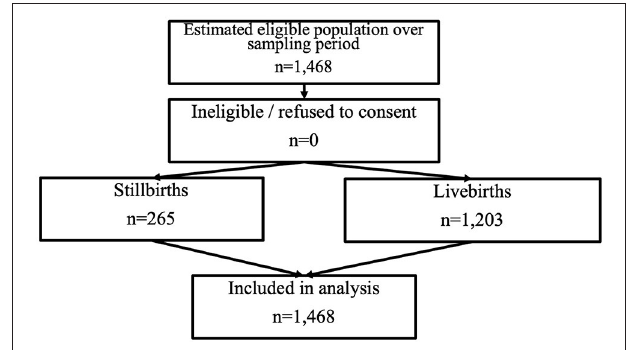
FIGURE 3 | STROBE (16) flow diagram for prospective cohort